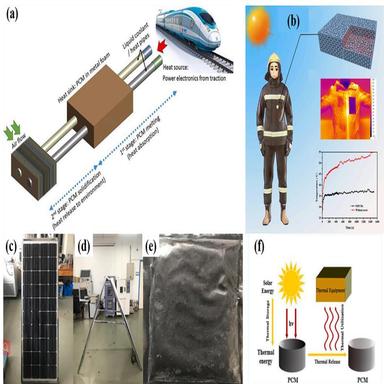
(a) Schematic of transient heat sink based on hydrated salt/metal foam composite in a power electronics, (b) temperature control test of an enclosed protective clothing, (c-e) photovoltaic heat dissipation system based on the hydrated salt/expanded graphite composite and (f) schematic of solar-tothermal conversion of sodium acetate trihydrate/expanded graphite composite . Reproduced with the permission of Elsevier.